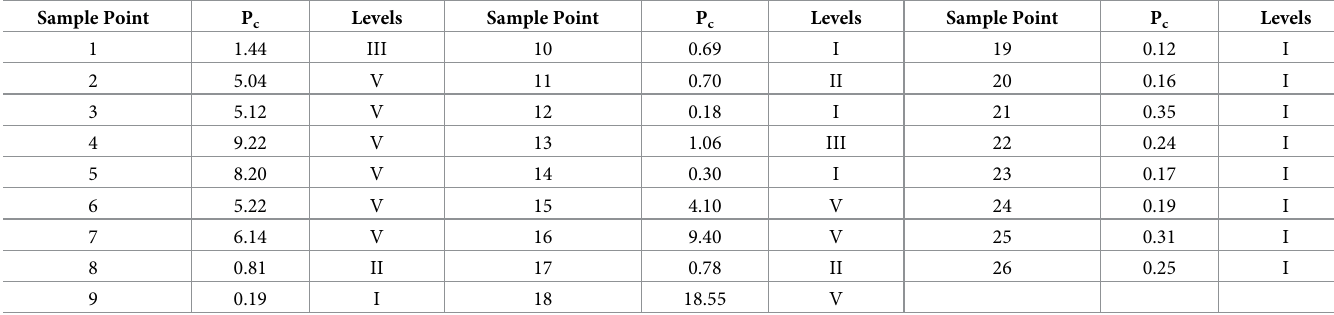
Fig 2. Box plots of heavy metals in Area A, B, C, D and background value. � BV = Background value, the BV of Cu, Ni, Pb, Zn refer to the soil background of Xi’an, Hg, As refer to the representative values of Background Values of Soil Elements in China (1990). https://doi.org/10.1371/journal.pone.0241398.g002 The I (Hg) of all seven sample points in area A were greater than 3.50, which belonged to geo strong pollution or extremely strong pollution, and the maximum value was 4.91. The I of sample points 15 and 16 in area C were 4.32 and 4.94 respectively, which belonged to strong pollution extremely strong pollution, and they were significantly higher than other points. The maximum value of I (Zn) was 3.88 at point 18. geo The RI results are shown in Fig 4. The RI values of sample points (1–7) in area A were all greater than 600. The maximum of RI can reach 1884 in point 4, and the average value of RI in area A was 1428. It dicateed that their PERs were significantly high and obviously larger than other areas. Through the analysis of E ri , Hg is the main cause resulting in the significantly high level of PER in area A. The RI values of sample points 8, 10, 11 in area B were 474, 495 and 506 respectively. They were high risk points. Similarly, it mainly resulted from the ecological risk Table 7. The results of CPI. Sample